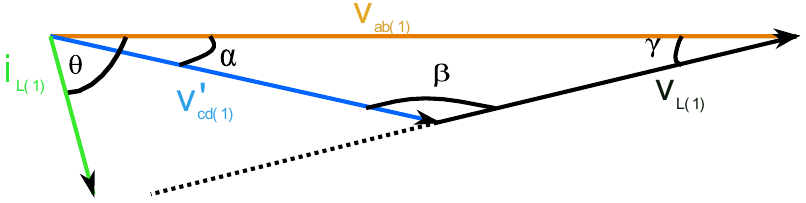
Figure 3. Phasor diagram representing fundamental components of voltages and current.